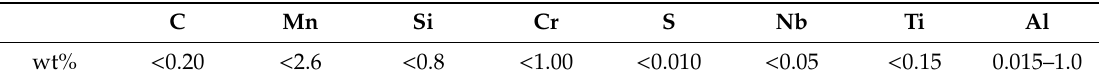
Table 1. Chemical composition of the investigated industrial steel grade.